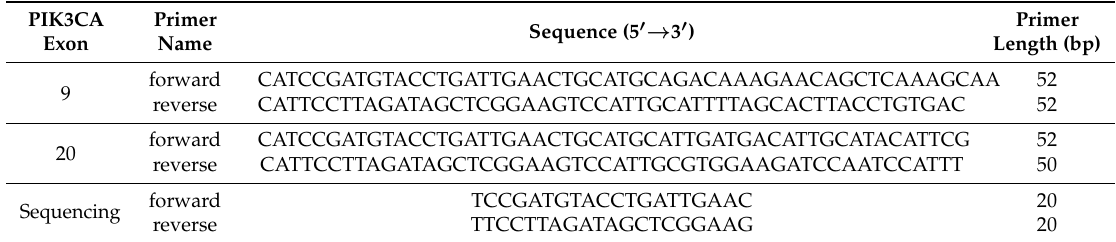
Table 3. Primer sequences for PCR amplification of exons 9 and 20 of PIK3CA and for Sanger